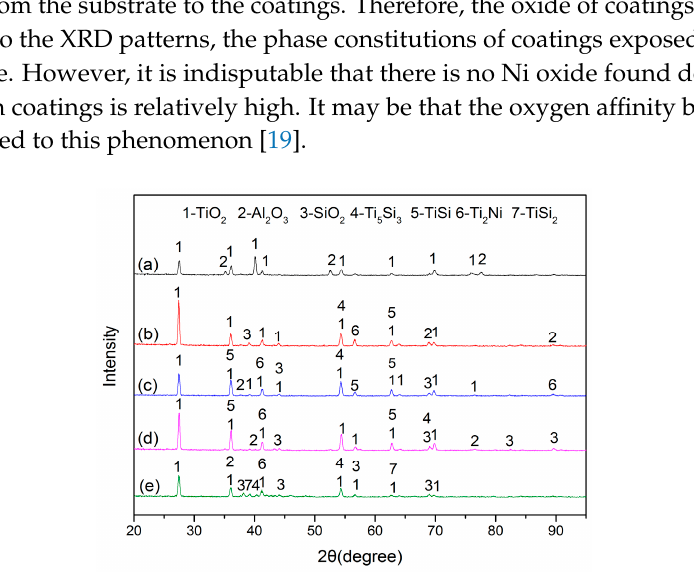
Figure 15. The XRD patterns of the specimens after oxidation test: ( a ) the substrate; ( b ) coating 1; ( c ) coating 2; ( d ) coating 3; ( e ) coating 4.